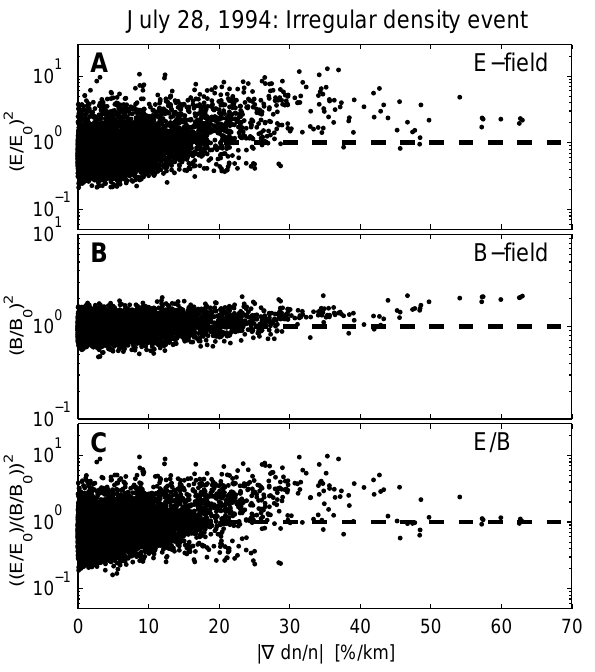
Fig. 5. Variations of the wave power for an LHC case. The analysis is based on 10s of data observed on 3 September 1993. Analysis and panels are the same as in Fig. 4. All points with enhanced elec- tric wave power and |∇ dn/n | & 40%/km are colored blue. From panel (B) we then see that there is no correlation between en- hancements in the electric power and enhancements in the magnetic power. 24